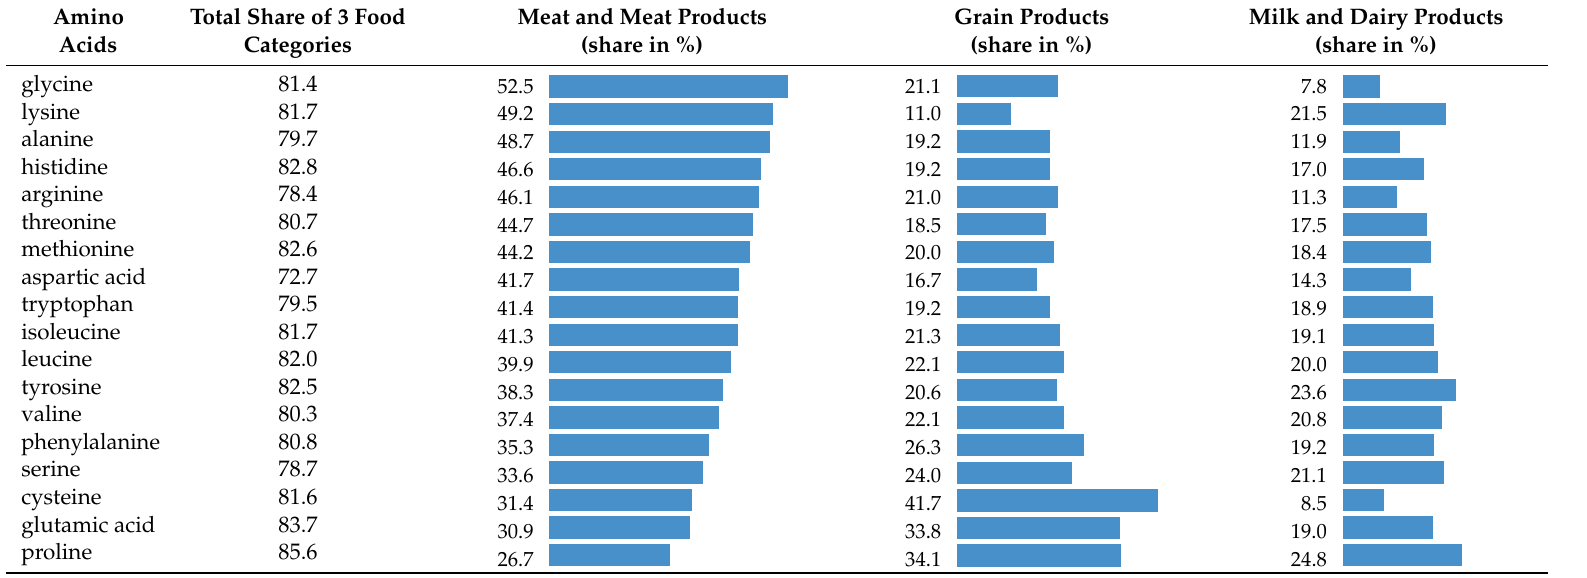
Table 7. The shares (in %) of three main food categories in the contribution of amino acids to the average Polish diet.